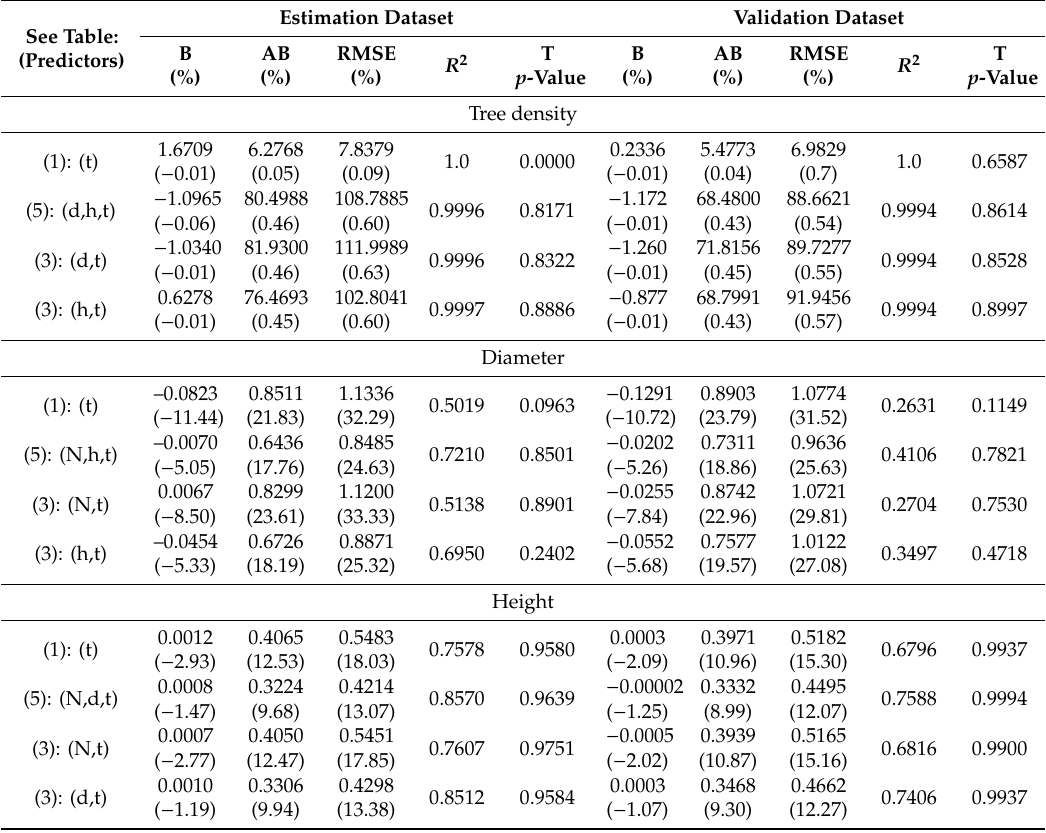
Table 14. Statistical measures and p -values of the Student’s t -test for the mixed-e ff ect scenario models. See Table: